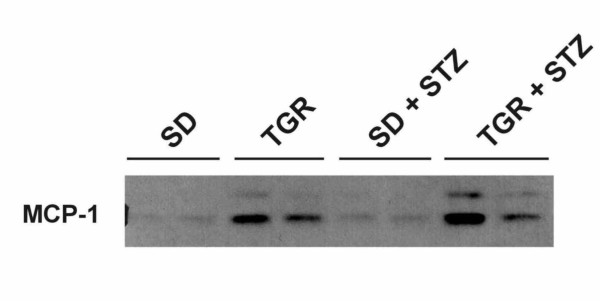
Western blot analysis for MCP-1 protein in cortical protein preparations of two rats of each experimental group, yielding the characteristic MCP-1 double band (14 and 16 kDa). SD, normotensive normoglycemic control rats; TGR, transgenic hypertensive rats; STZ, streptozotocin treatment.